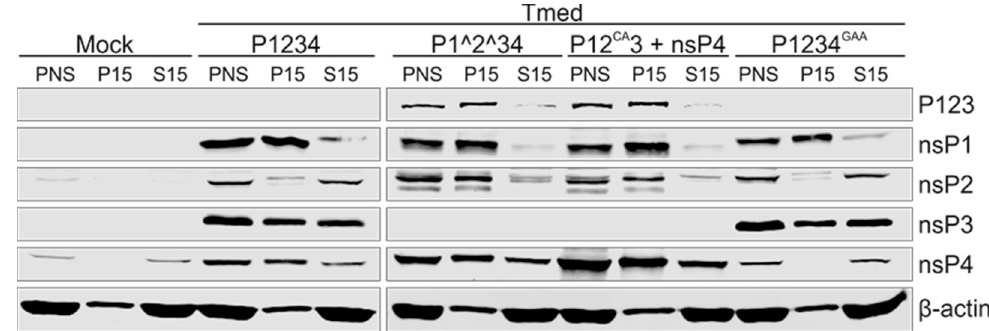
Figure 2. Distribution of nsPs expressed in transfected cells. BSR cells were transfected with the replicase plasmid(s) indicated at the top and Tmed template plasmid. At 16 h post transfection, PNS was prepared and fractionated into P15 and S15, and nsPs were detected by Western blotting with specific antibodies. The polyprotein P123 was recognized using anti-nsP3 antibody. β -actin was used as a cytosolic marker. Equivalent amounts of PNS, P15, and S15 were loaded. Two independent experiments were performed and one representative result is shown